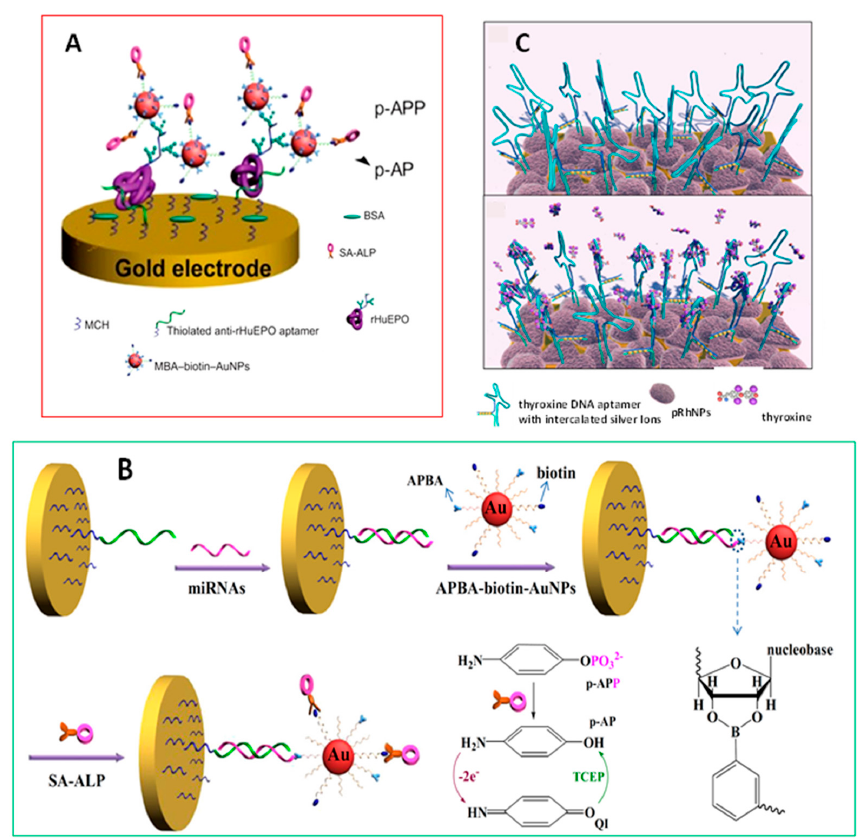
Figure 2. Schematic display of ( A ) the signal-amplified electrochemical biosensor for the detection of rHuEPO glycoprotein by using MBA-biotin-AuNPs as labels; ( B ) the label-free detection of miRNAs based on the triple signal amplification of APBA-biotin-AuNPs, SA-ALP, and the p-APredox-cycling reaction; and ( C ) the thyroxine biosensor in conditions of (up) absence and (down) presence of the analyte. Reproduced from [34] ( A ), [35] ( B ), and [38] ( C ) with